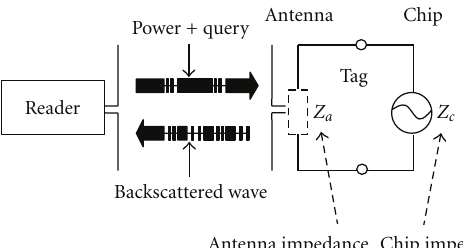
Figure 1: Principle of back-scattered UHF RFID